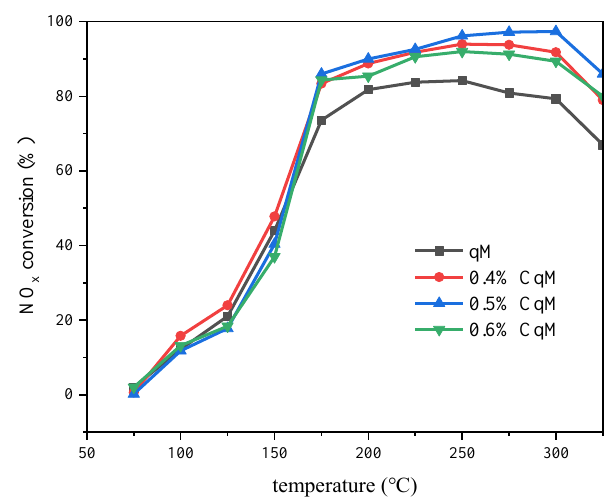
Figure 7. NO x conversions over various catalysts. Reaction condition: [NH 3 ] = 500 ppm, [NO] = 500 ppm, [O 2 ] = 4%, and N 2 balance, the gas hourly space velocity (GHSV) = 79,000 h −1 .